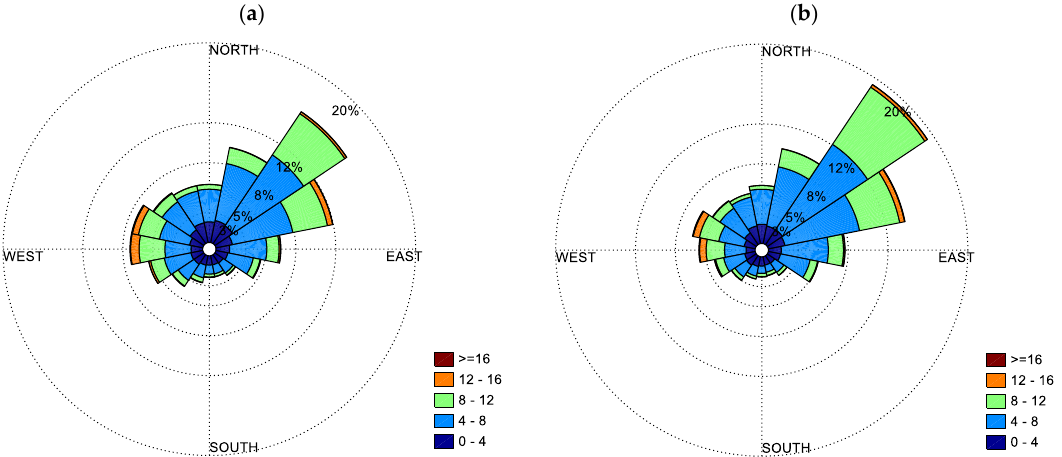
Figure 3. Wind roses for wind at the surface in Lisboa for ( a ) historical and ( b ) future climates. Each colour represents an interval of wind speed. Sixteen directional divisions. The circles mark the number of occurrence (in percentage) for each wind direction (16 direction bars were considered).